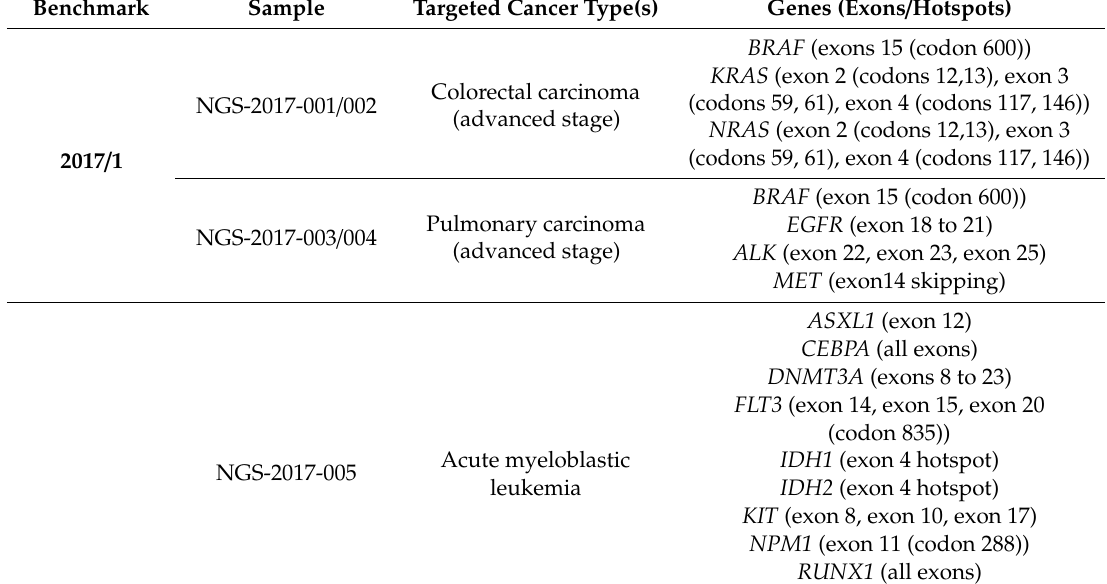
Table 2. Overview of samples and their targeted cancer types and genes to be evaluated by laboratories for each benchmark. All clinically relevant genes of the targeted cancer types are displayed, regardless of whether they were mutated or not in the sample. See also Supplementary Table S6 for a full overview of all samples with their targeted transcript and protein, as well as ordered variants and expected variant